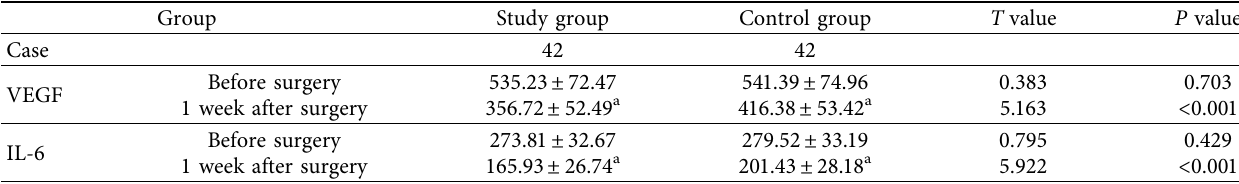
Table 3: Serum VEGF and IL-6 levels were compared in two groups (pg/mL, x ± s ).